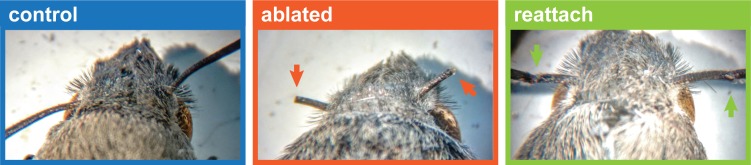
Antennal surgery.To obtain flagella ablated animals, the flagella were cut between the 5th and 10th annulus (red arrows in middle panel). The flagella were preserved and re-attached to the same individual with a small amount of super glue (green arrows, right panel).